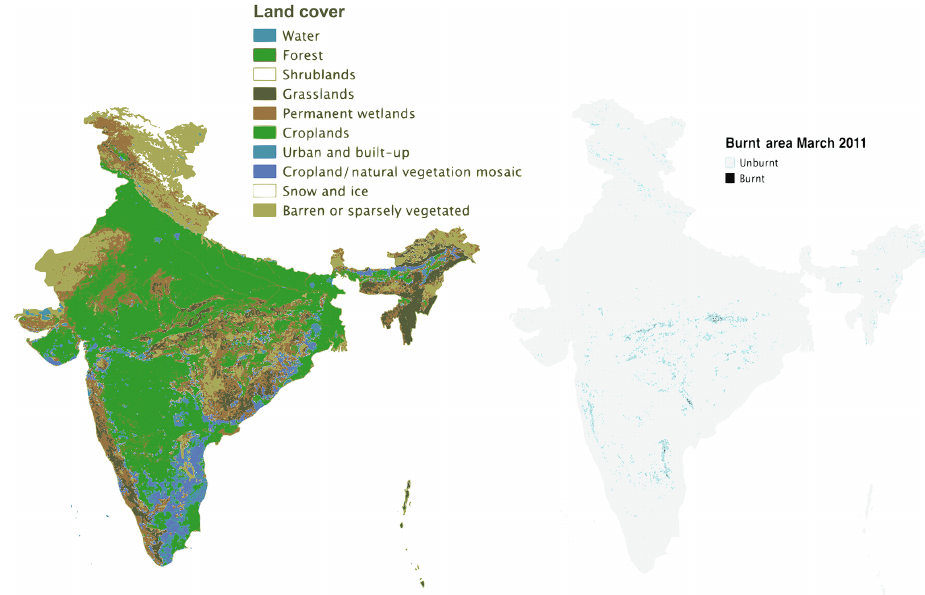
Figure 4. Land cover and burnt area for March